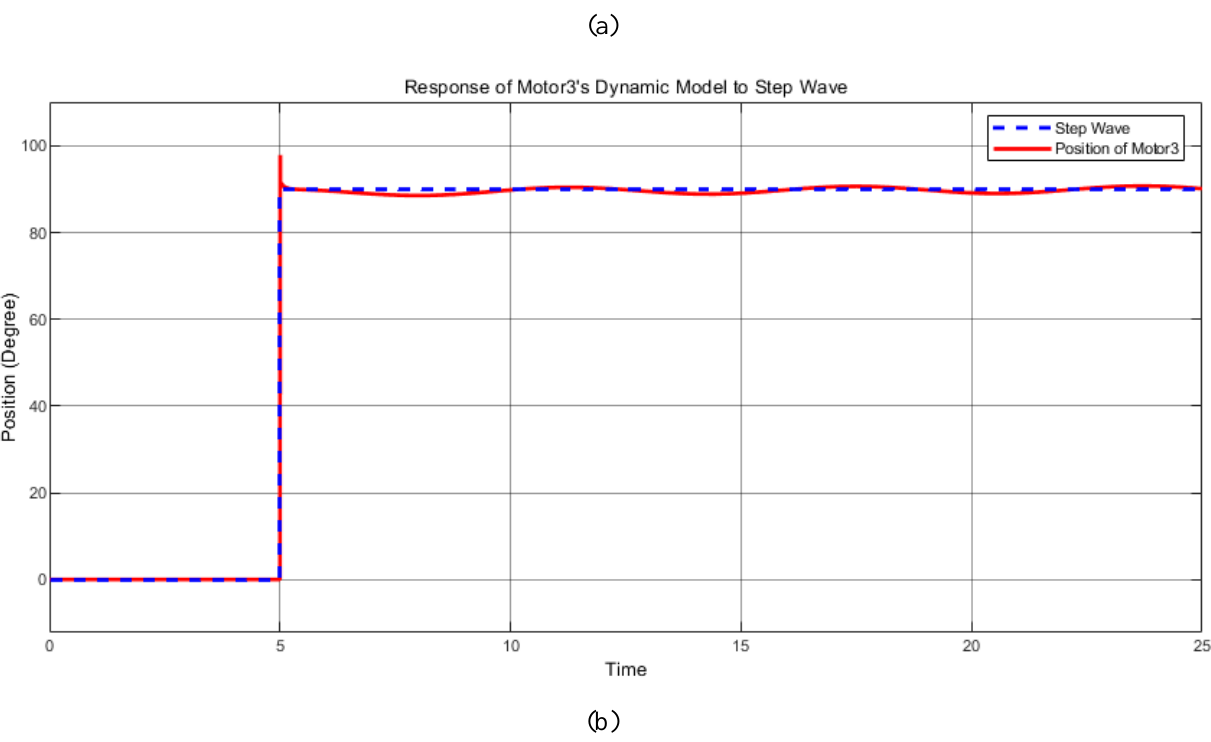
Figure 16. Joint 3 response a) sinus input, b) step